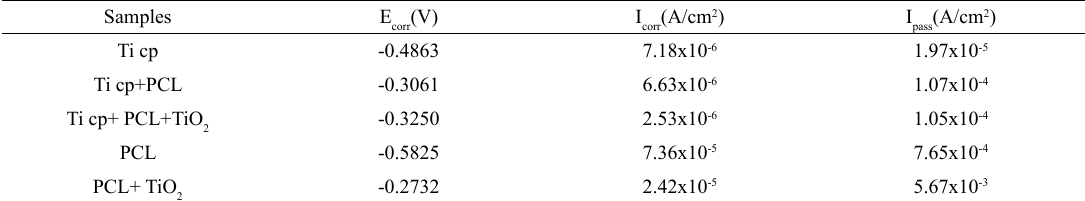
Figure 5. Micrographs obtained by Scanning Electron Microscopy and EDS spectra obtained at the point A: (a) PCL film, (b) PCL+TiO film, (c) Ti cp+PCL, and (d) Ti cp+ PCL+TiO Table 2. Corrosion Test results at physiological